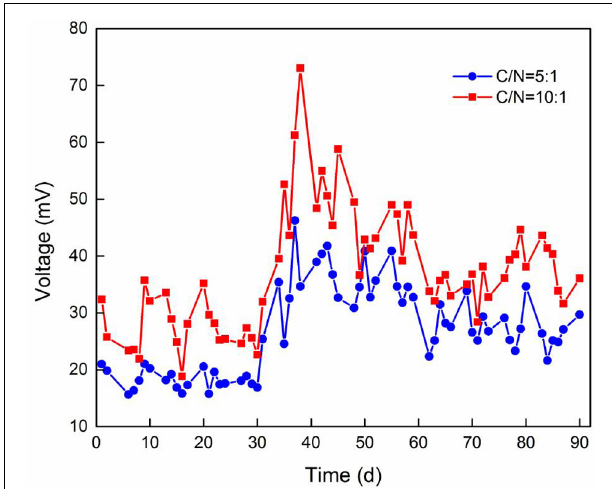
FIGURE 3 | Voltage output of two TFCW-MFC devices operated with various C/N